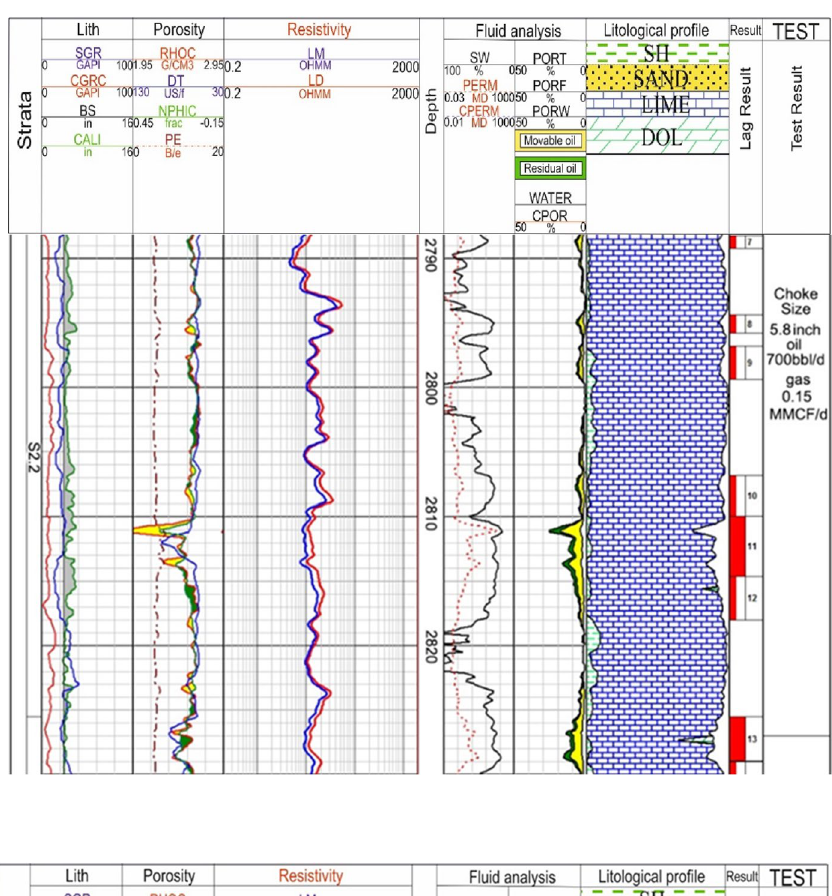
Fig. 15 Composite well log for production zones within depth interval 2830–2860